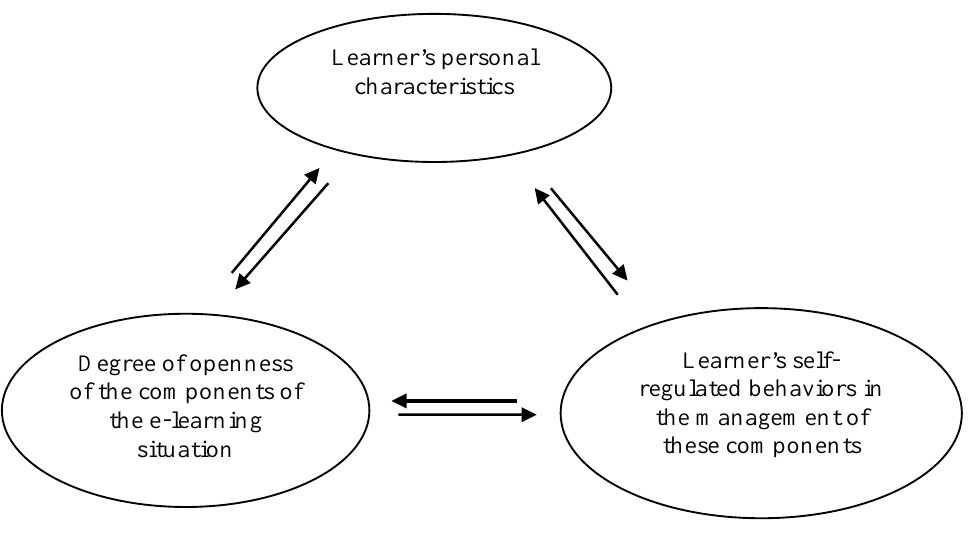
Figure 2 . The triadic reciprocal causality model applied to the empirical research presented in this